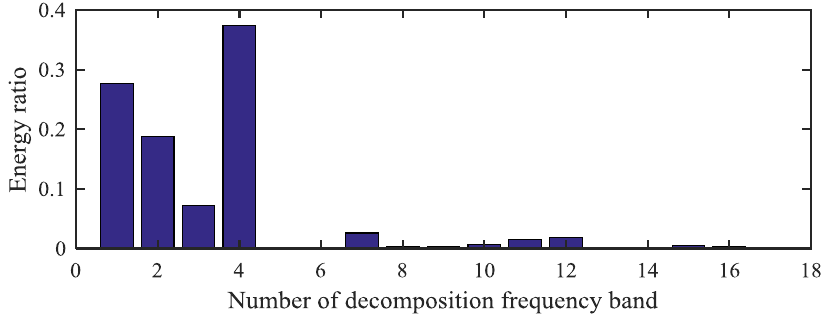
Figure 9. The raw vibration signal of the faulty bearing: ( a ) the waveform and ( b ) spectrum.